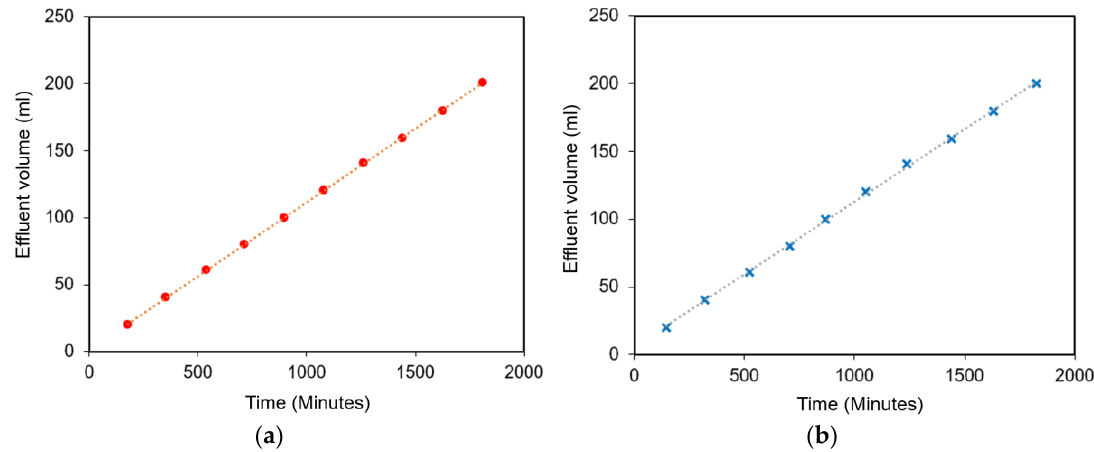
Figure 3. Plots of effluent volume as a function of time for hydrolyzed polyacrylamide (HPAM) polymer concentrations of 3000 mg/L ( a ) and 3300 mg/L ( b ) in the filtration ratio tests. The slope denotes the filtration ratio. It can be seen that a slop of 1.0 was obtained for the concentration of 3000 mg/L and a slop of 1.08 was obtained for the concentration of 3300 mg/L.